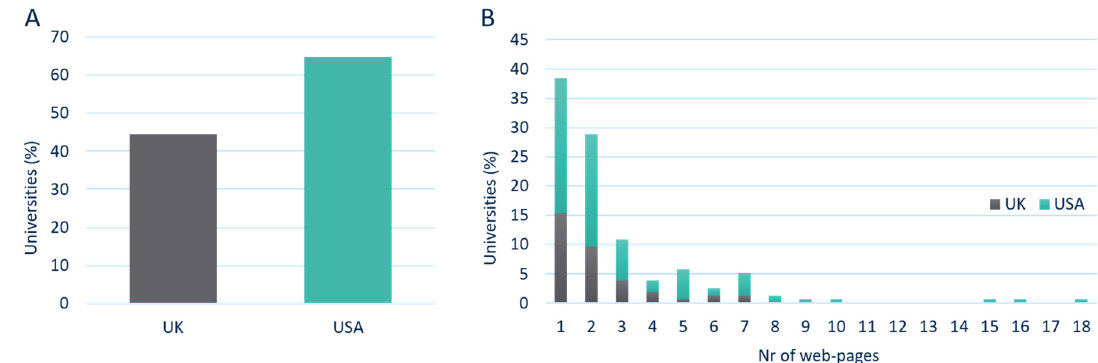
Figure 1. Results showing how many universities have regulatory web presence; ( A ) percentage of universities per country that mentioned regulation; ( B ) number of URLs mentioning regulation across all universities that had some kind of web presence on this topic.